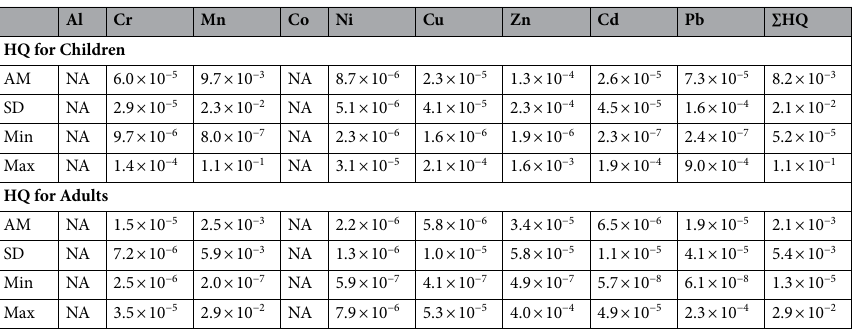
Table 10. Statistical parameters of the estimated HQ for different HMs in potable water of the study area.